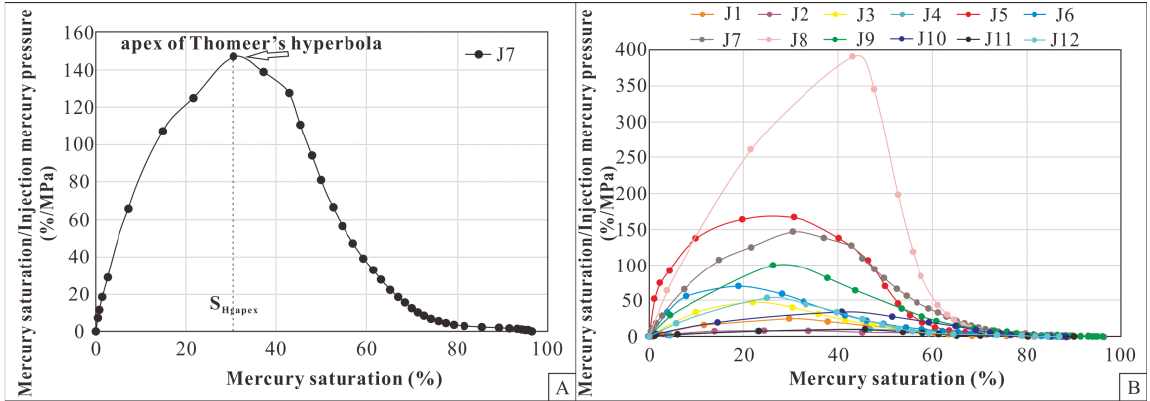
Figure 7. ( A ) The plot of Sample J7, showing the apexes of Thomeer’s (1960) hyperbola; ( B ) plot of mercury saturation/capillary pressure versus mercury saturation for the 12 typical samples. The relationship between r apex and porosity and permeability is shown in Figure 8; r apex has a strong correlation with porosity (R 2 = 0.7818) but a weaker correlation with permeability (R 2 =